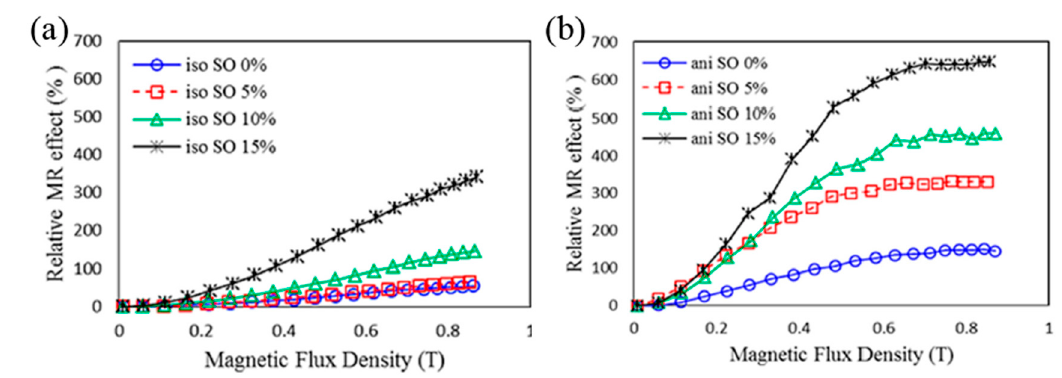
Figure 8. Relative MR effect for ( a ) isotropic MRE and ( b ) anisotropic MRE as a function of magnetic field for different SO contents [97].